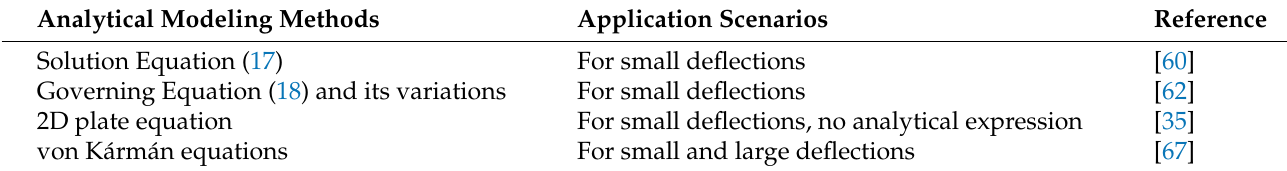
Table 3. Analytical modeling methods of membrane deflections of CMUTs in collapse